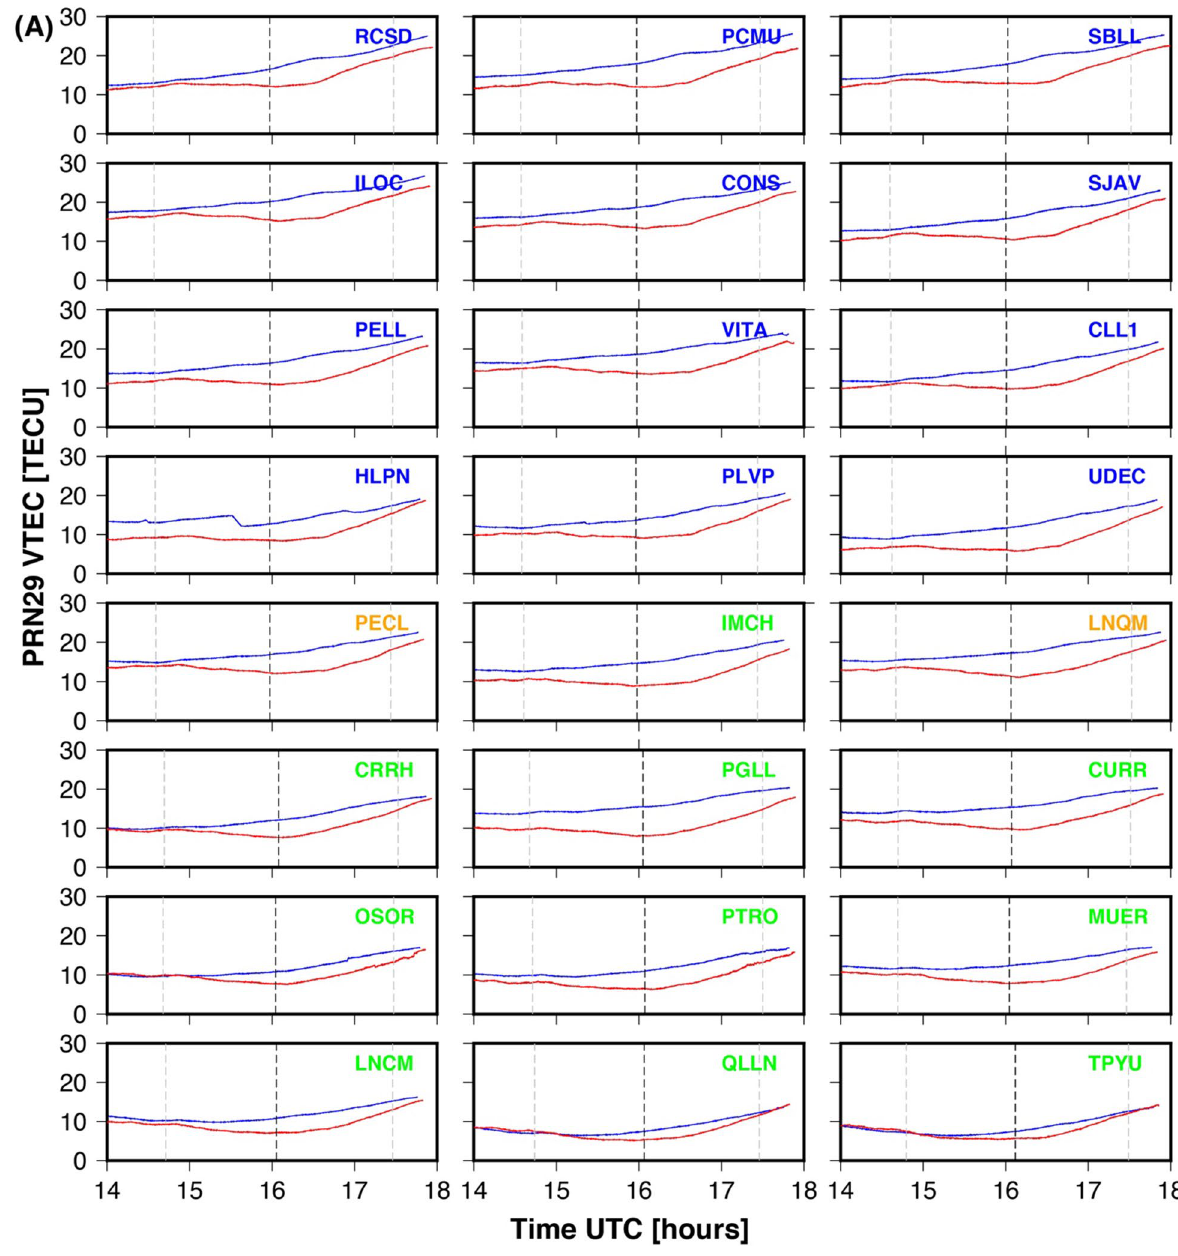
Figure 2. ( A ) The VTEC plots of the PRN29. The red color line shows the average VTEC before and after the total solar eclipse day as DOY 348 and 350. The blue color line shows the VTEC on the Total solar eclipse day as DOY 349. The down subplot shows the reduction of the VTEC of GPS sites from north to south. ( B ) The VTEC plots of the PRN31. The red color line shows the average VTEC before and after the total solar eclipse day as DOY 348 and 350. The blue color line shows the VTEC on the Total solar eclipse day as DOY 349. The down subplot shows the reduction of the VTEC of GPS sites from north to south. The plots are arranged from bottom (South: GPS sites name in green color) to the top (North: GPS site named with blue color). The GPS sites in totality region named with orange color. Eclipse magnitude at each site added at the upper left corner. The grey dotted vertical line is showing maximum eclipse time at each site. The Figure is prepared using the GMT 5.4.5 37